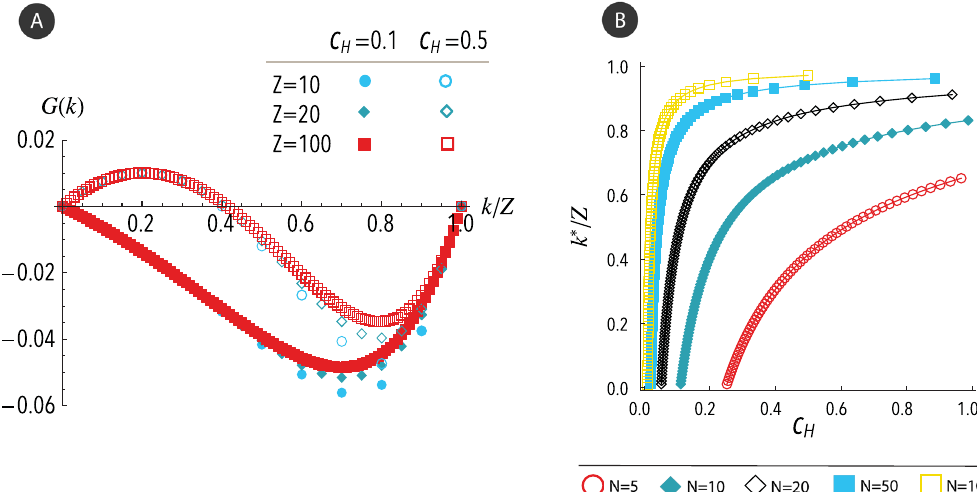
Figure 2. Gradient of selection and equilibria of the N-person Hawk-Dove Game in finite populations. ( a ) Gradient of selection G ( k ) in the N-person HDG as a function of the discrete fraction k / Z of doves, for different population sizes Z and a sample size of N = 5. Different shapes of symbols represent different population sizes Z = 10, 20, 100, while solid ( resp ., empty) symbols represent a cost of c H = 0.1 ( resp ., 0.5). ( b ) Equilibria of the N-person Hawk-Dove Game in finite populations for different values of cost c H , and a population size of Z = 100. Symbols denote the required values of c H for which there exists an equilibrium at k / Z . Note that, for finite populations, k / Z takes discrete values. Different symbols represent different sample sizes N . Other parameters are R = 1, w =